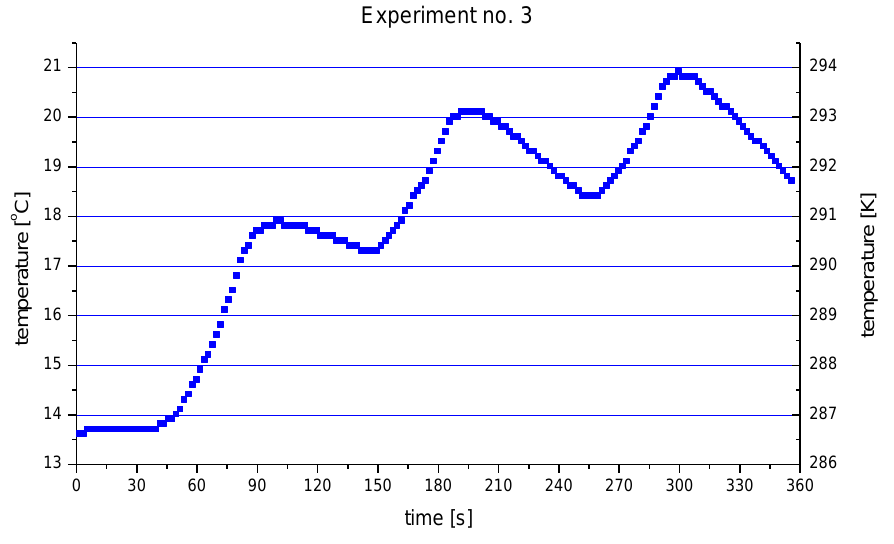
Figure 7. Outlet cooling water temperature in the experiment no. 3 simulating the deposition of HA with the use of the water flow rate of Q = 0.5